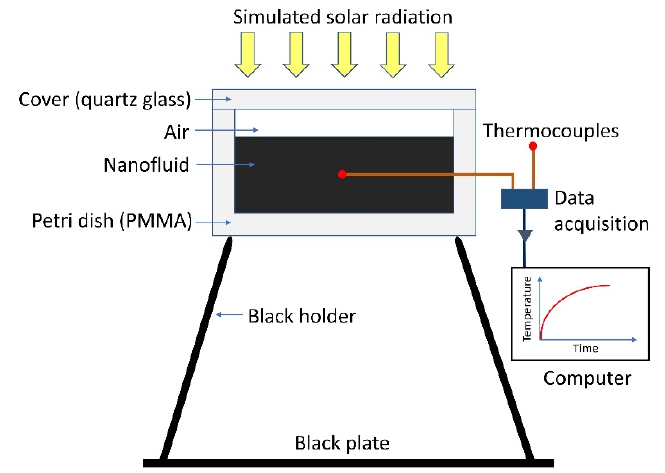
Figure 2. Schematic of the experimental solar–thermal conversion setup used to measure the time-dependent temperature variation of nanofluids exposed to simulated solar irradiation.